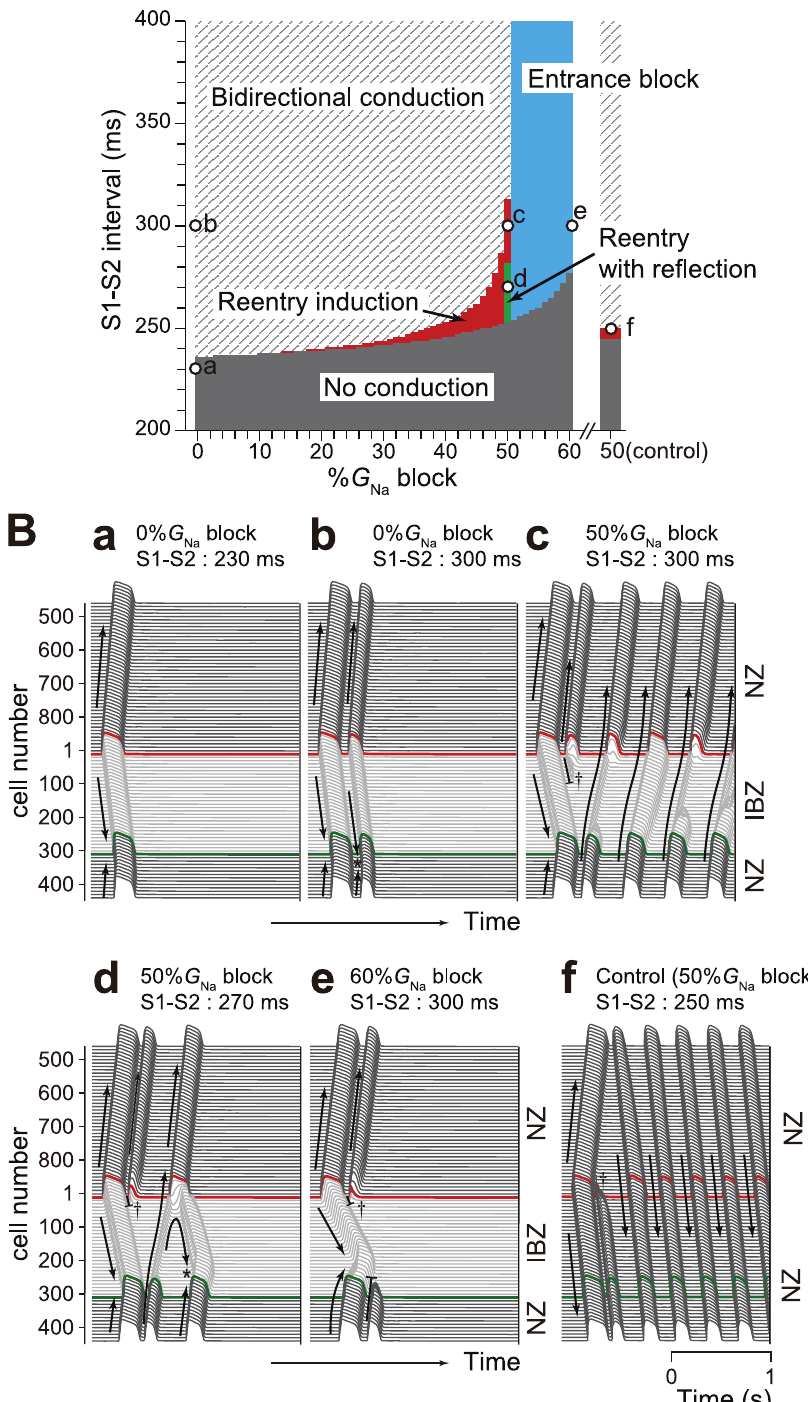
Figure 5. Reentry induction by Na + channel blockade in myocardial ring models. (A), Phase diagram of % G Na block vs. S1–S2 interval showing proarrhythmic events under Na + channel blockade in the myocardial ring model. Right bar (control): responses to S2 stimulus in the myocardial ring constructed of only NZ myocytes under 50% G Na block. (B), Examples of AP propagation in response to S1–S2 interval. Arrows and black short bars indicate the directions of AP propagation and entrance block, respectively.